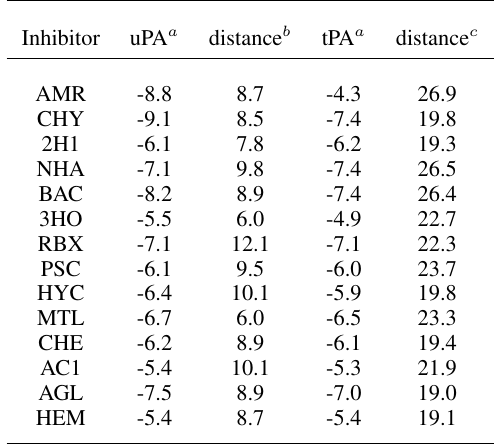
Table 1. Calculated affinity of protein/inhibitors complexes and their distance from specificity pocket.